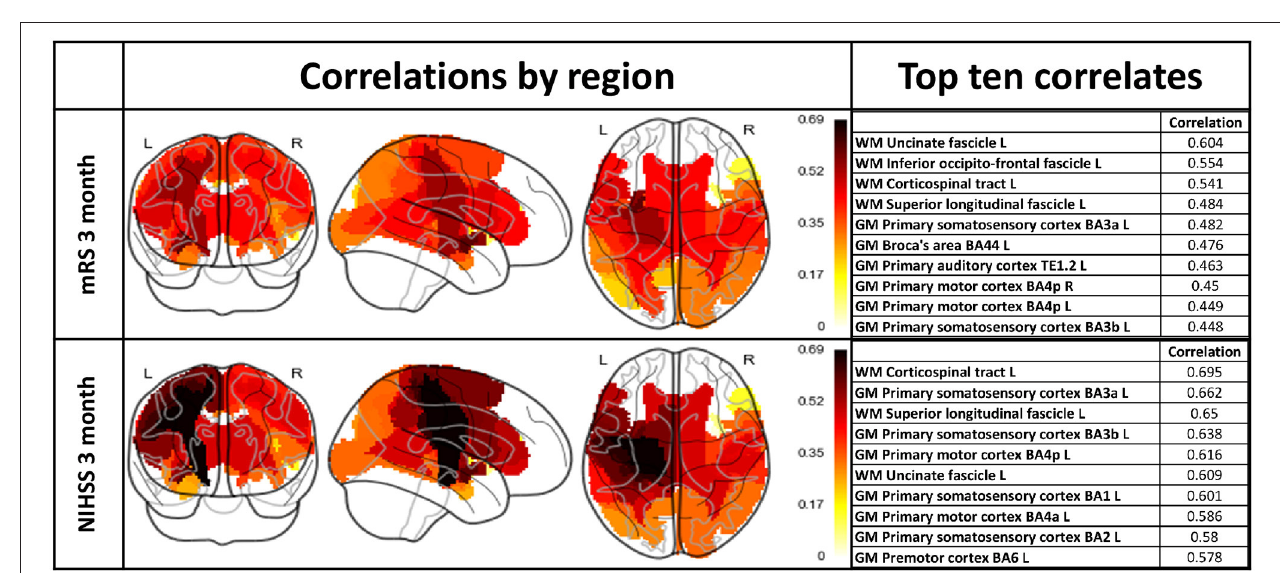
FIGURE 4 | Lesion load correlations with 3 month mRS and NIHSS scores including the whole patient cohort. Left column: Visualization of regional lesion load correlations with clinical assessments. Right column: Top ten correlating regions with respect to outcome scores.